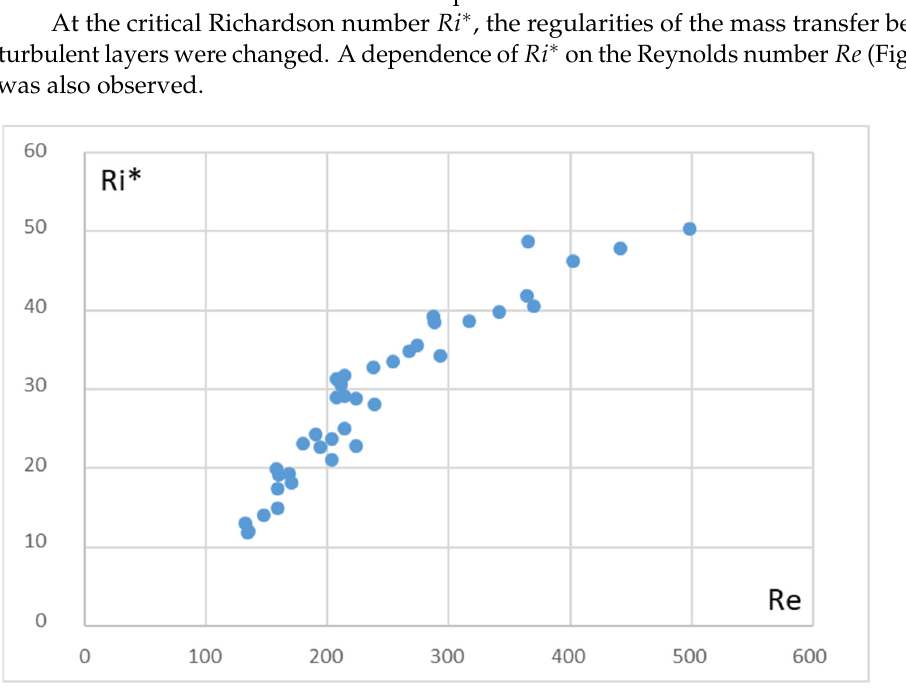
Figure 11. The critical Richardson number (cid:1844)(cid:1861) ∗ as a function of the Reynolds number (cid:1844)(cid:1857)